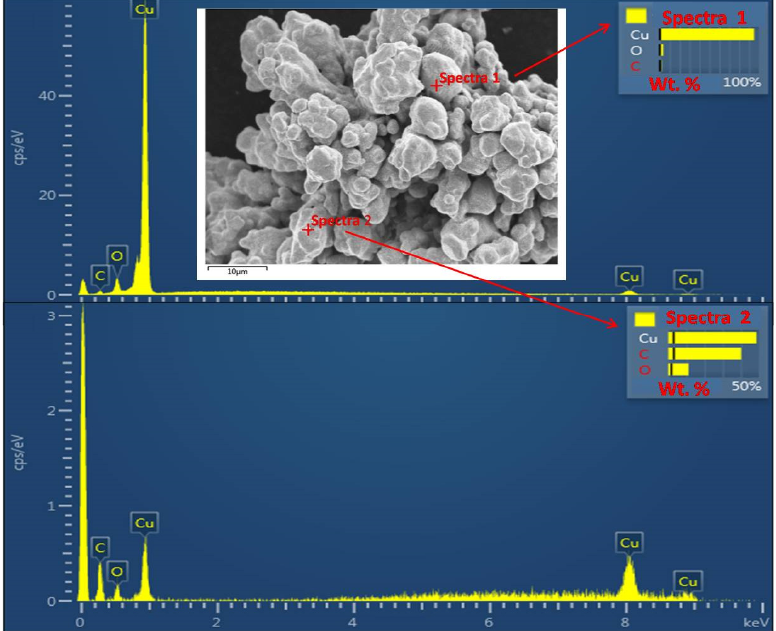
Figure 7. EDS spectrum of the partially oxidized copper powder (the original commercial sample).